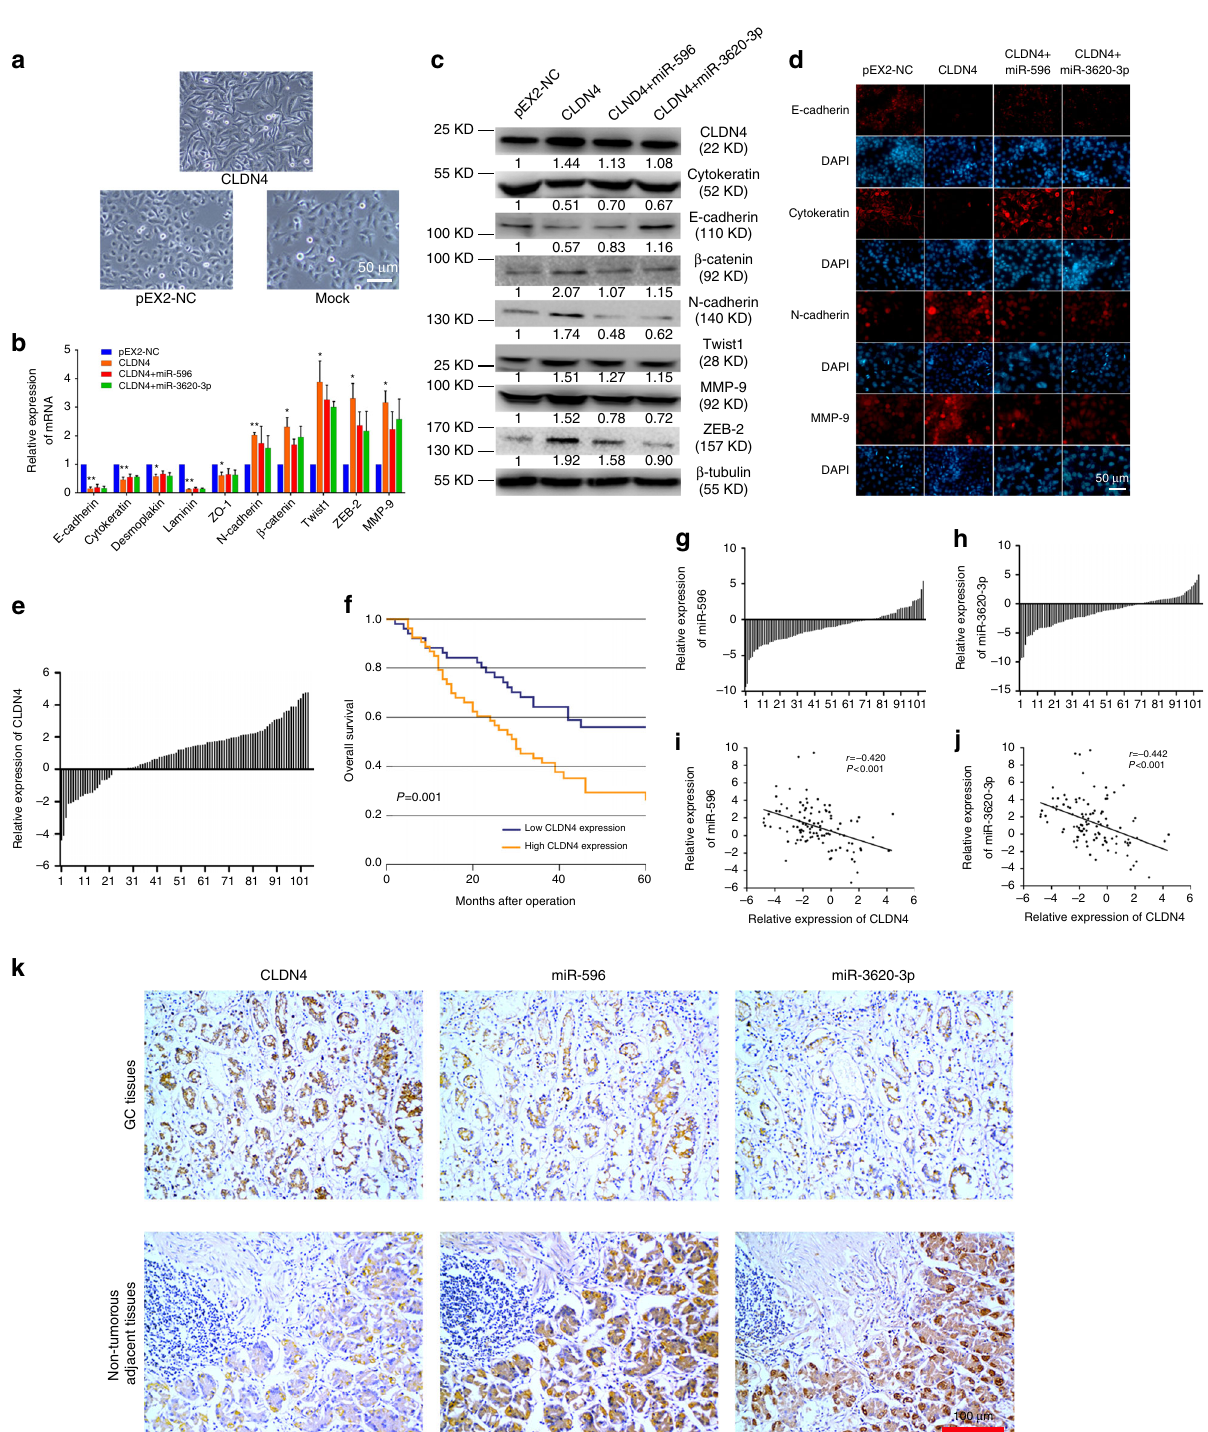
Fig. 3 CLDN4 induces EMT in vitro. a Phase-contrast micrographs of CLDN4 overexpressing cells, pEX2-NC cells and SGC-7901 cells. Scale bars = 50 μ m. b , c The transcriptional and translational levels of EMT related markers. The real-time PCR and western blotting were performed at 48 h after the CLDN4 overexpressing cells treated with mimics of miR-596 or miR-3620-3p. d Immuno fl uorescence microscopy of the localization and expression of EMT and invasion markers in CLDN4 overexpressing cells. Scale bars = 50 μ m. e The relative expression levels of CLDN4 in human GC tissues compared with their matched non-tumorous adjacent tissues. f Kaplan – Meier analysis of the correlation between CLDN4 expression levels and overall survival. g , h The relative expression levels of miR-596 and miR-3620-3p in human GC tissues compared with their matched non-tumorous adjacent tissues. i , j The correlation between CLDN4 transcriptional levels and miR-596 or miR-3620-3p transcriptional levels were measured in the same set of patients by Spearman correlation analysis. k Representative images of CLDN4, miR-596 and miR-3620-3p expression from GC tissues and non-tumorous adjacent tissues by ISH assays. Original magni fi cation × 200. Scale bars = 100 μ m. Data are shown as mean ± s.d., n = 3. The data statistical signi fi cance is assessed by Student ’ s t -test and Wilcoxon ’ s Sign Rank Test is used to evaluate the differential expression between GC tissues and their matched non-tumorous adjacent tissues. * P < 0.05, ** P <